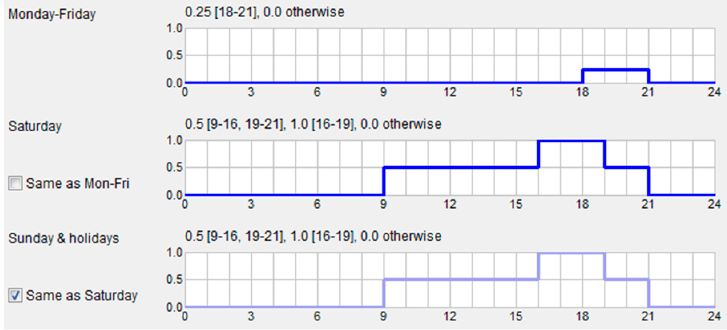
Figure 11. Scheduled internal loads of spectators.